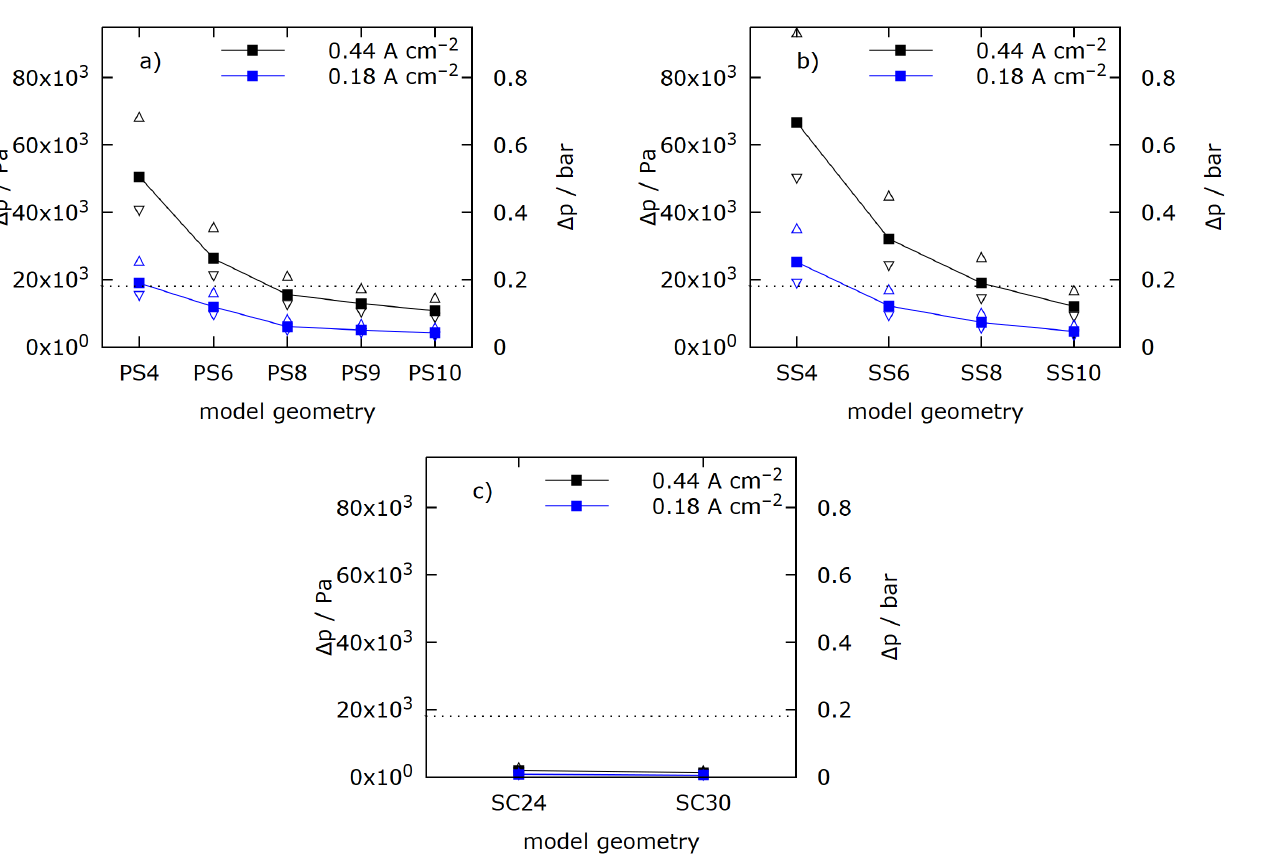
Figure 10. Pressure difference for the cathode flow fields. (cid:52) / (cid:53) show results for a variation of ± 0.05mm in channel depth. ( a ) parallel serpentine; ( b ) separate serpentine; ( c ) straight channels; dotted line at target value of 0.18